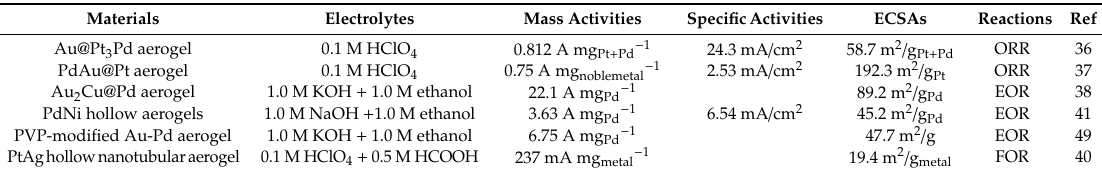
Table 1. Electrochemical characterization of